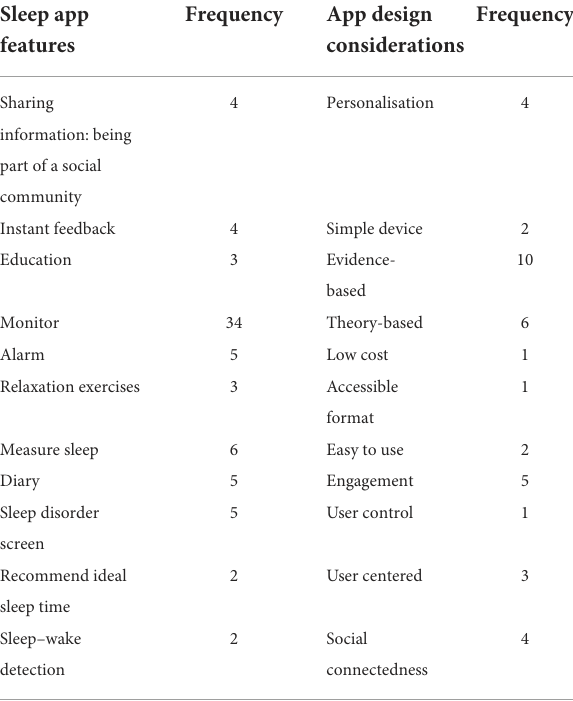
TABLE 1 Some key features of sleep apps and design